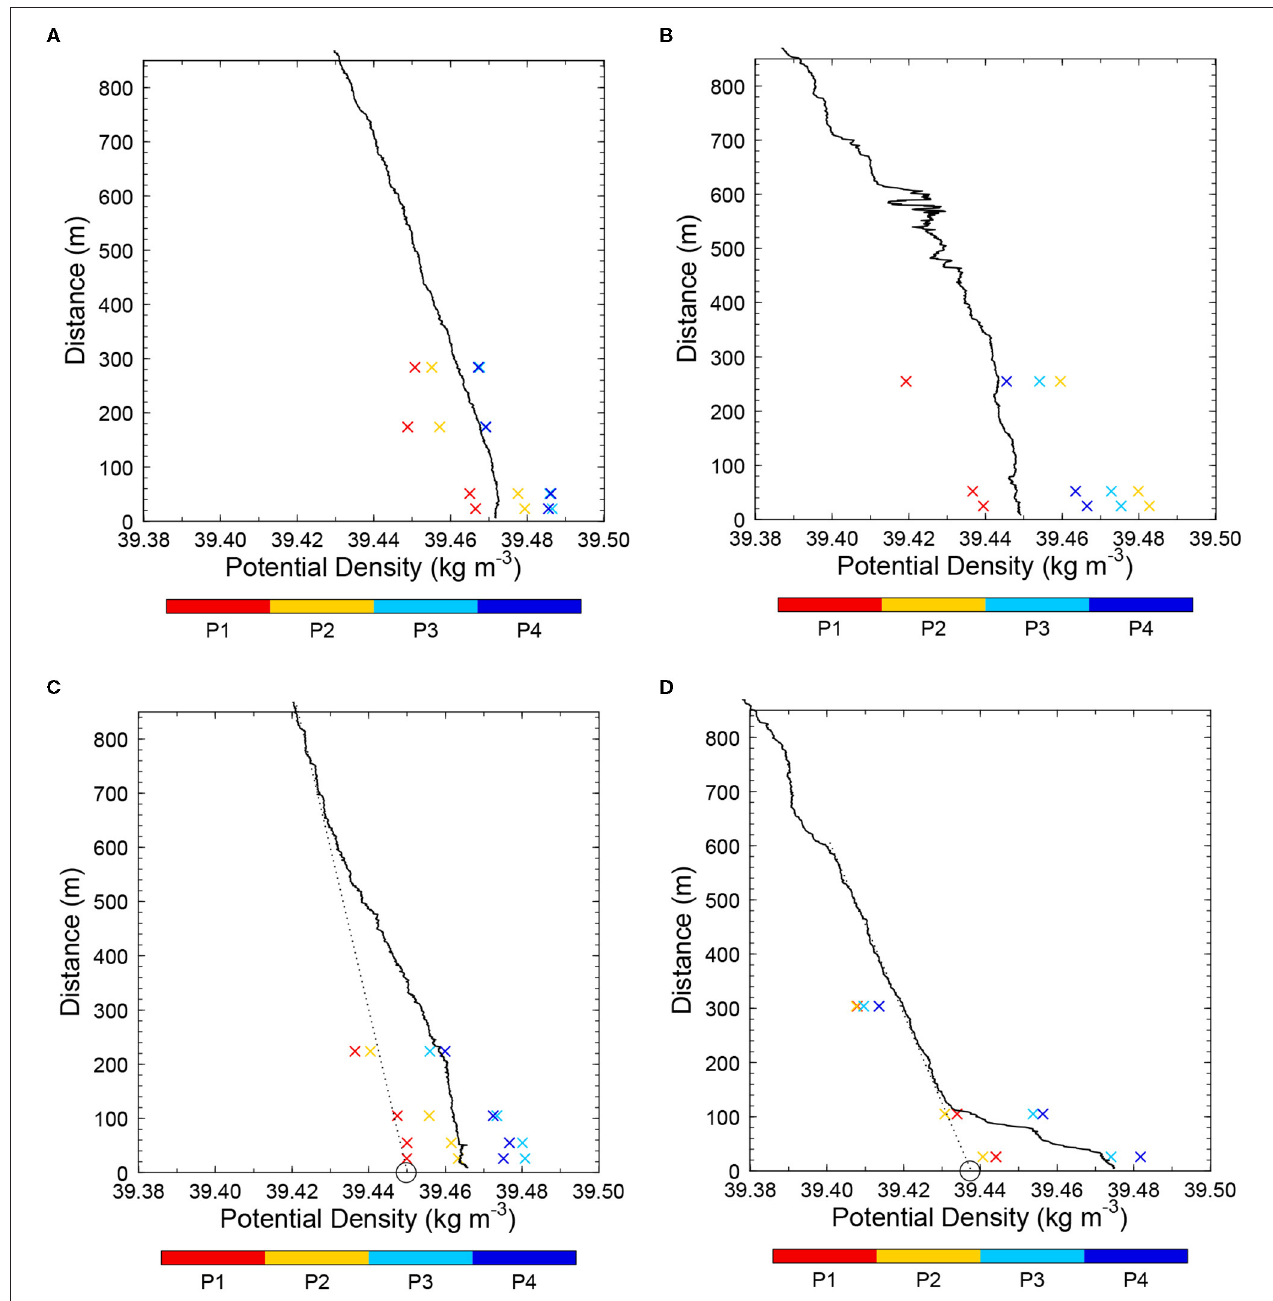
FIGURE 7 | Seasonal variability of the vertical distribution of σ 25 at mooring (A) M1, (B) M2, (C) M3, and (D) M4. The vertical axis indicates the distance from the bottom. The red, orange, light blue, and blue crosses indicate mean σ 25 in periods P1, P2, P3, and P4, respectively. The solid lines in (A–D) indicate the vertical distribution of σ 25 at CTD stations, a03, a05, b02, and c03, respectively. The circles and dotted lines in (C,D) indicate values of σ Ab and fitting lines used in section 3, respectively. The details are discussed in the text.